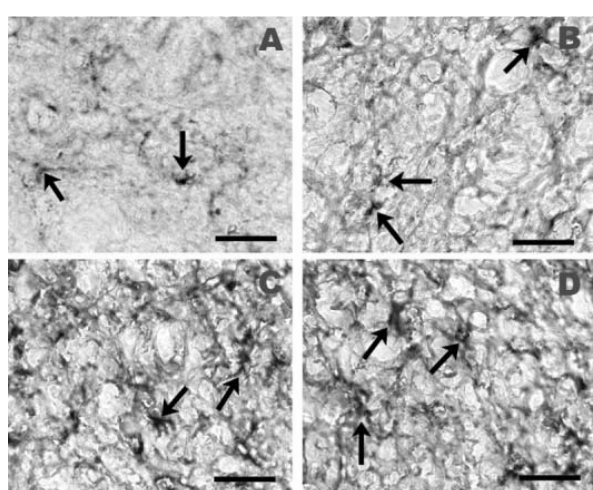
FIGURE 3 - Microphotographs showing glial fi brillary acidic protein (GFAP), a marker for